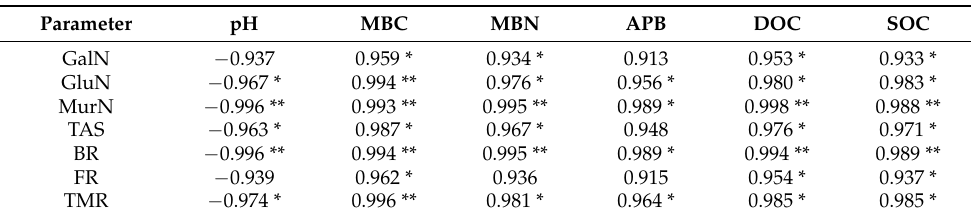
Table 4. Pearson’s correlation analysis between microbial amino sugar components and soil biochem- ical properties in 2018.